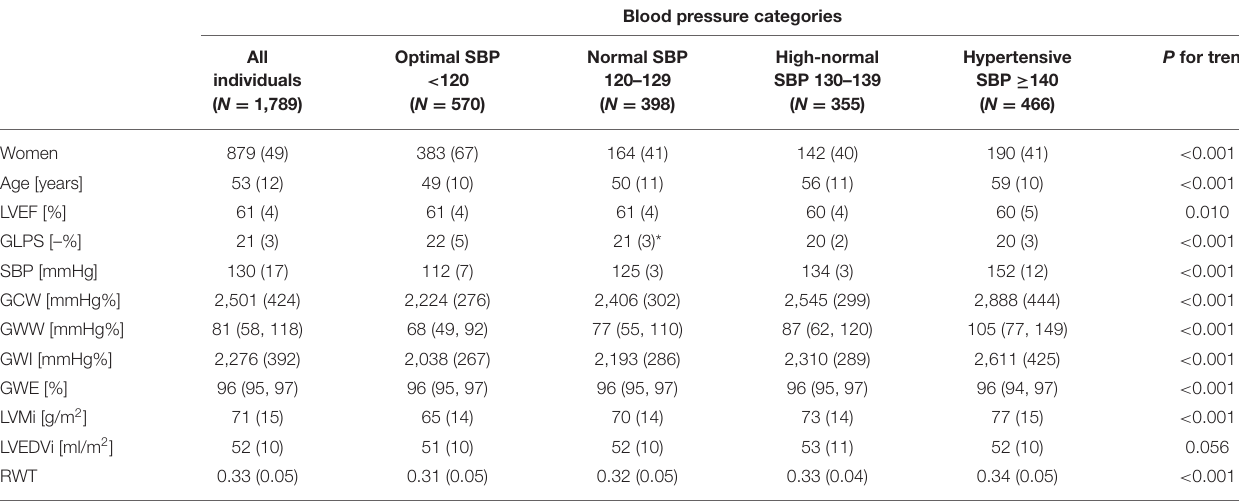
TABLE 5 | MyW indices in individuals with normal LV geometry according to blood pressure category.